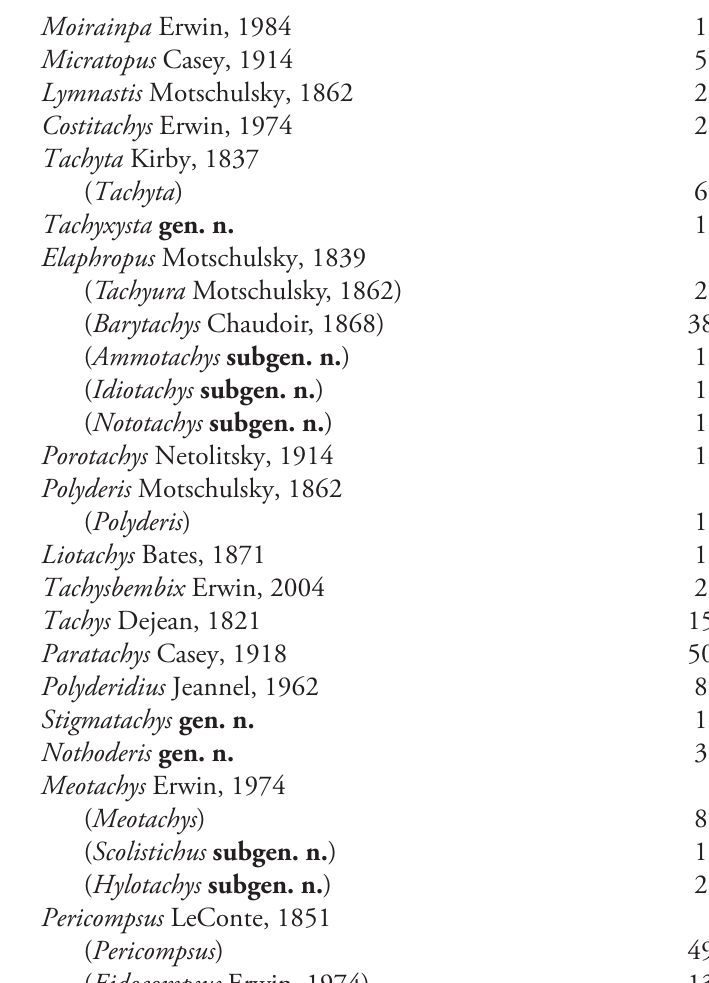
Label data are listed verbatim, with label breaks denoted as follows: “label data” / “begin new line on label” // “begin second